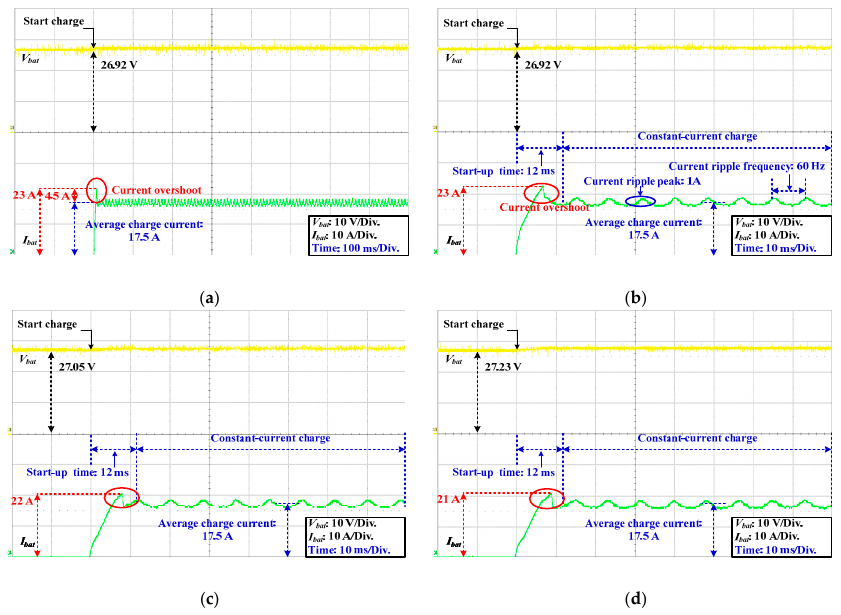
Figure 24. Using the ZBFS method and setting f zc = 5 kHz. ( a ) Start-charge voltage: 26.92 V, SOC: 30%, time scale: 100 ms/div. ( b ) Start-charge voltage: 26.92 V, SOC: 30%, time scale: 10 ms/div. ( c ) Start-charge voltage: 27.05 V, SOC: 50%, time scale: 10 ms/div. ( d ) Start-charge voltage: 27.23 V, SOC: 70%, time scale: 10 ms/div.